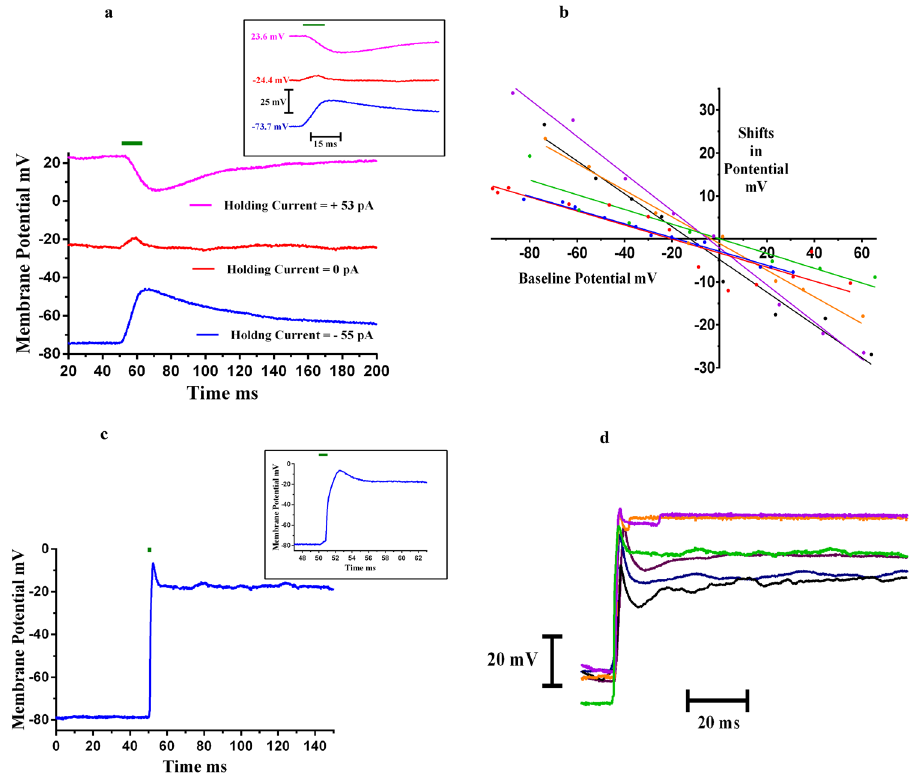
Figure 4. Activation of SH-SY5Y Neural Cells – Whole Cell Current Clamp Recording. ( a ) When a 532 nm green laser (denoted by the green bar), 10 ms pulse, having a power of 100 mW was shined on the tip of the nanoelectrode, a change in cell membrane potential was observed. The inset shows the onset response in more detail (faster time scale). The recordings were done in whole cell current clamp configuration. The figure shows shift in evoked potentials at three different baseline potentials; − 73.7 mV (applied holding current = − 55 pA), − 24.4 mV (applied holding current = 0 pA) and + 23.6 mV (applied holding current + 53 pA). ( b ) The change in evoked potential varied with membrane potential; positive for − 30 mV or less, and negative for 20 mV or more. Shifts in evoked potential vs baseline membrane potential for six different cells are shown, each represented by a different colour. ( c ) For 1–5 ms laser pulses (75–120 mW laser power), action potentials were recorded from the SH-SY5Y neural cells. The figure shows a representative action potential recorded from an SH-SY5Y cell for a 1 ms laser pulse at 100 mW laser power. The inset shows the zoomed portion of the onset response of the same. The cell membrane baseline potential was − 78.5 mV (applied holding current =− 35 pA). ( d ) Action potentials recorded from the six different neural cells, each cell shown in a different colour. All the experiments were done in whole current clamp mode using an electrophysiological patch clamp